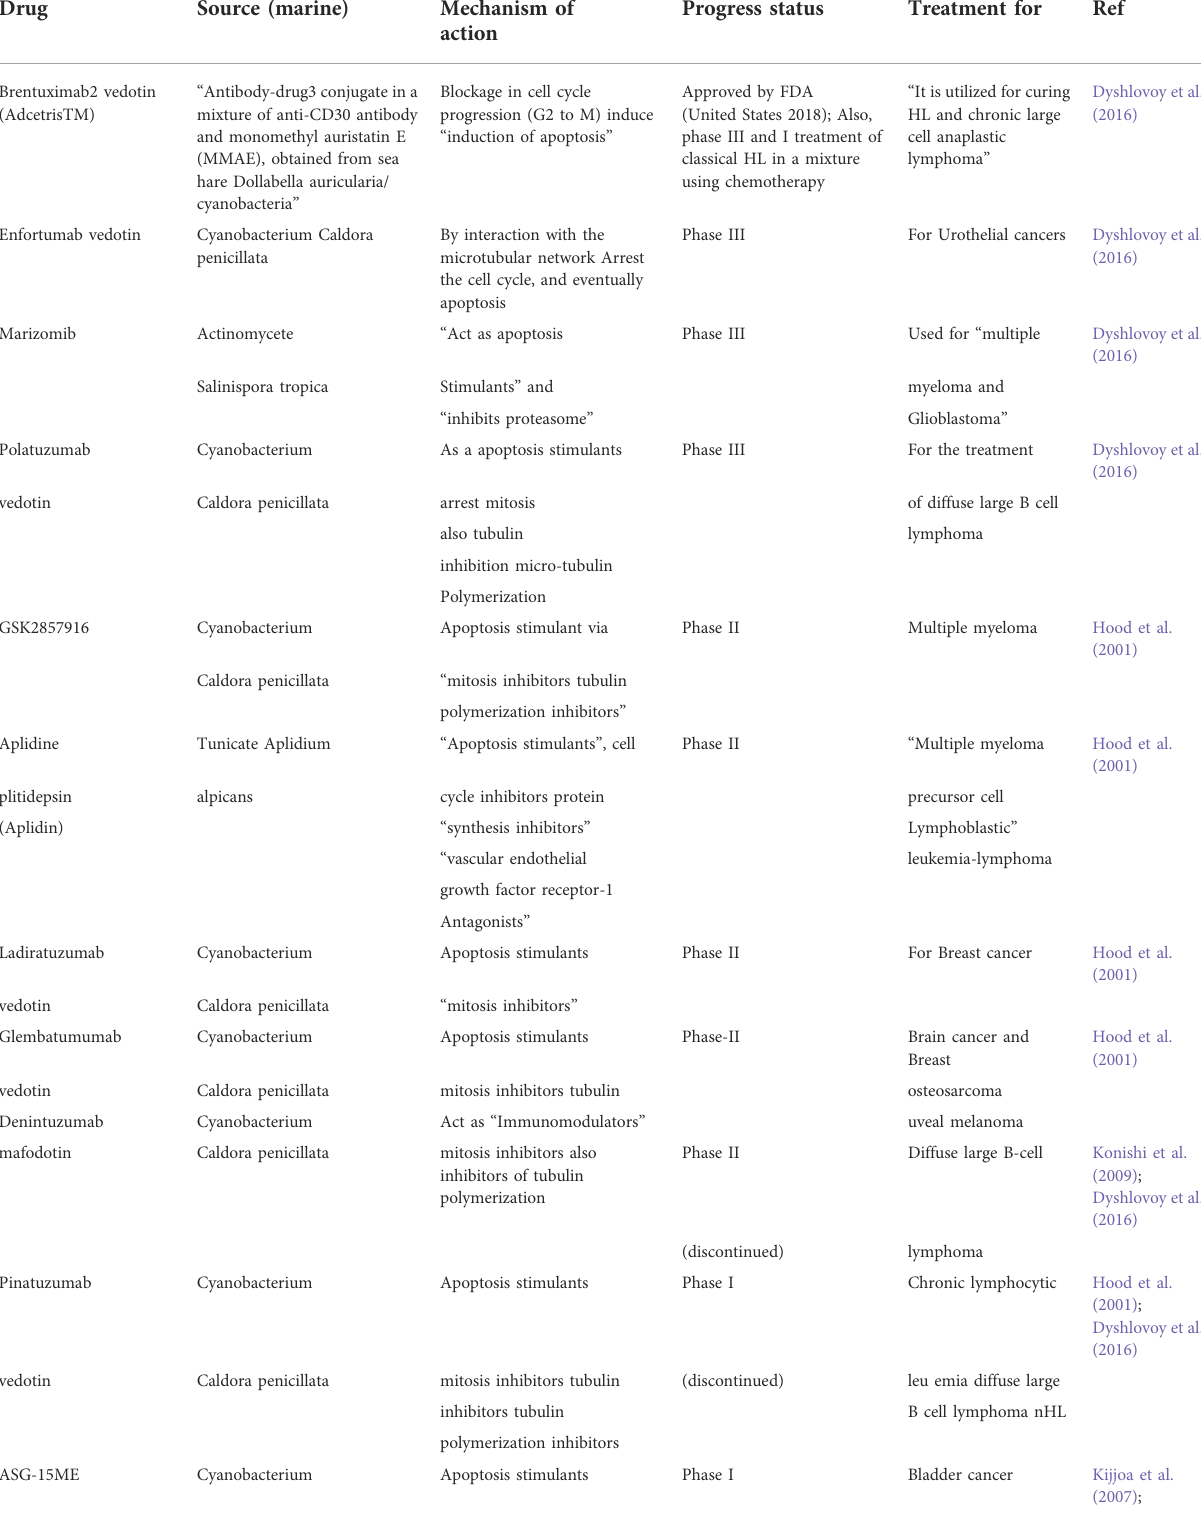
TABLE 3 Marine base drugs (FDA Approved/treatment Phase) as Apoptotic